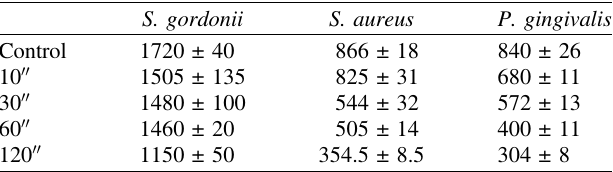
Table 1. Time effect of sonication on the growth of planktonic bacteria analyzed by microplating. Shown are the colony counts.